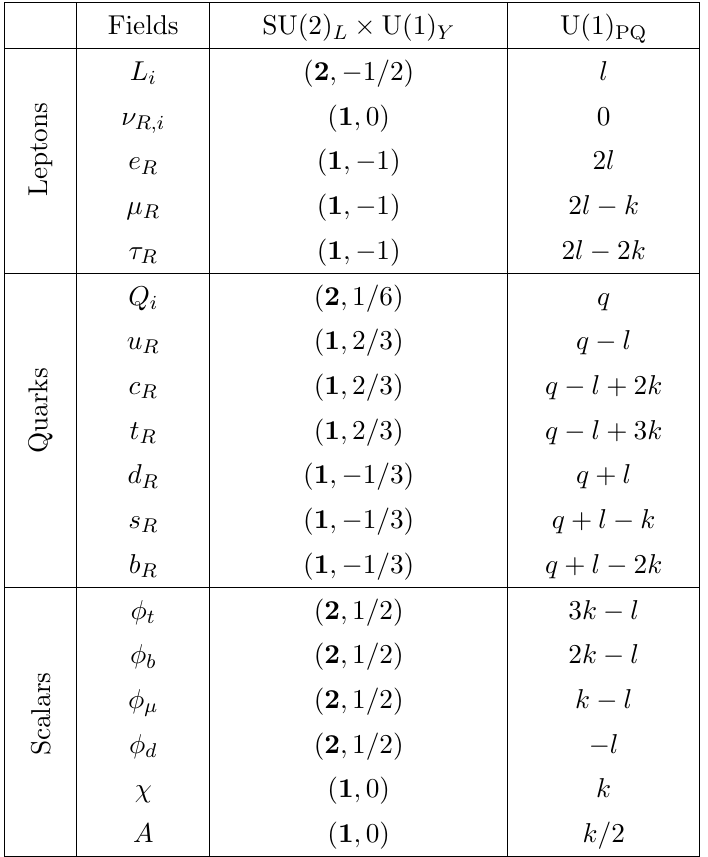
Table 1 . Particle content and symmetry transformations under the EW gauge group and U(1) PQ symmetry. All the scalars are color singlets while only the quarks transform non-trivially under SU(3) C . The Lagrangian and charges have been checked using Sym2Int [47].